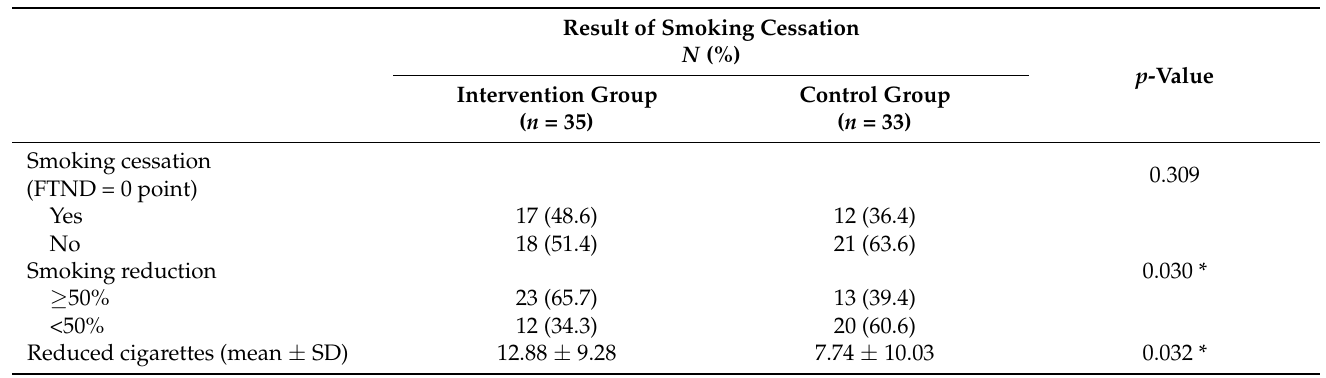
Table 2. Result of smoking cessation between study groups.